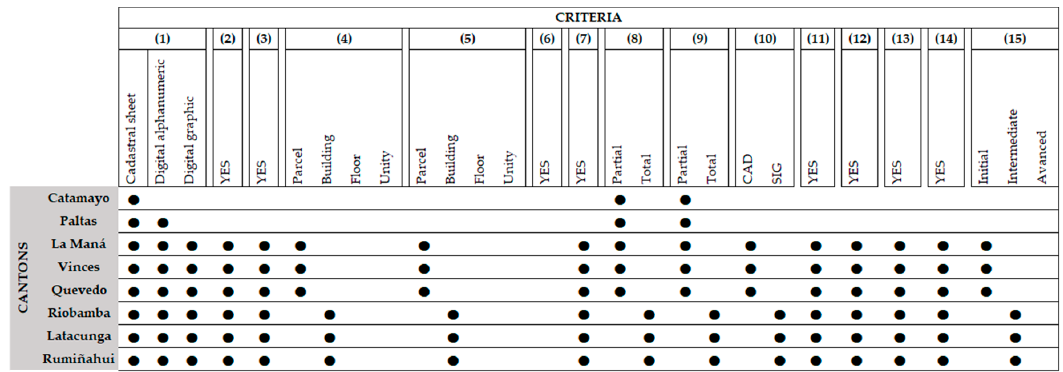
Figure 3. Summary of the interviews by cantons considering the established criteria.